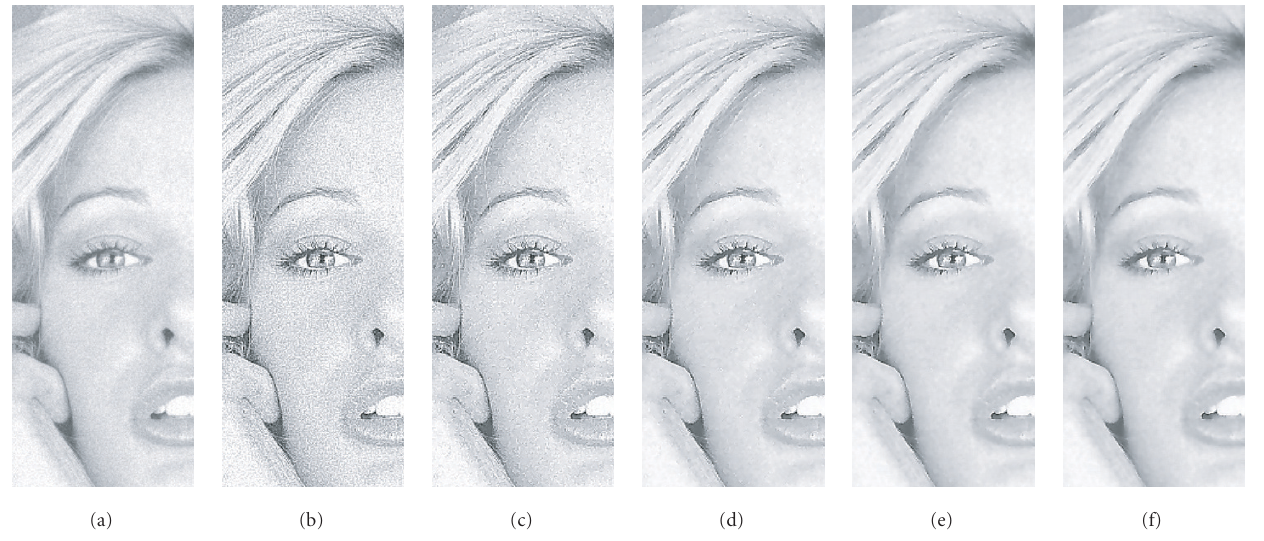
Figure 8: (a) Detail of noisy image, and results given by di ff erent parameter settings: (b) k sh = 5 and k sm = 0, (c) k sh = 5 and k sm = 5, (d) k sh = 5 and k sm = 10, (e) k sh = 5 and k sm = 15, and (f) k sh = 5 and k sm = 20.